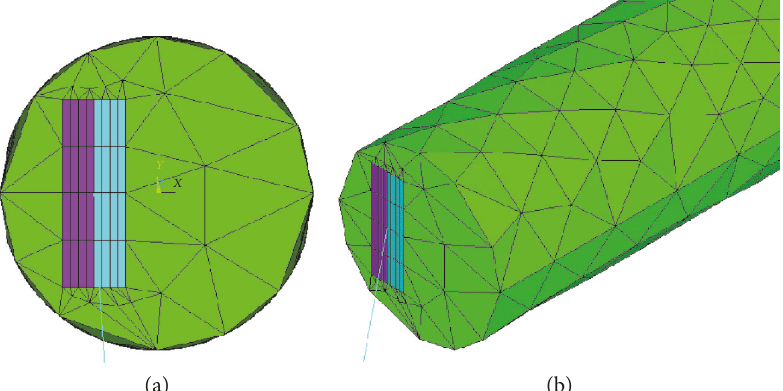
Figure 5: Simpli fi ed model of the tendril ’ s internal structure. (a) Cross-sectional area of the tendril body with the G-cell section close to the left lateral wall; (b) isometric view of the 3D model of the entire tendril body, with the spring element used to apply the force exerted by the plant